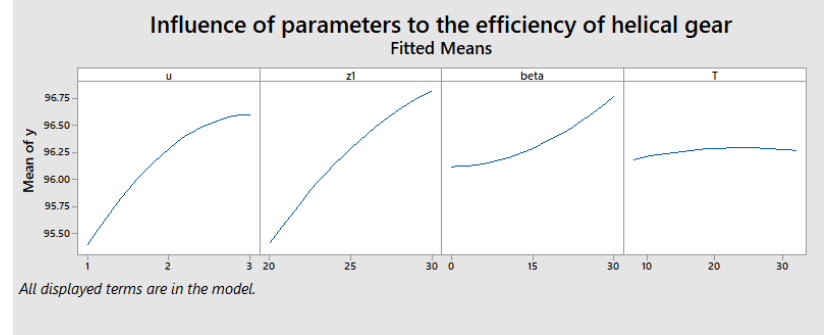
Figure 2. Influence of parameters to the efficiency of helical gear.